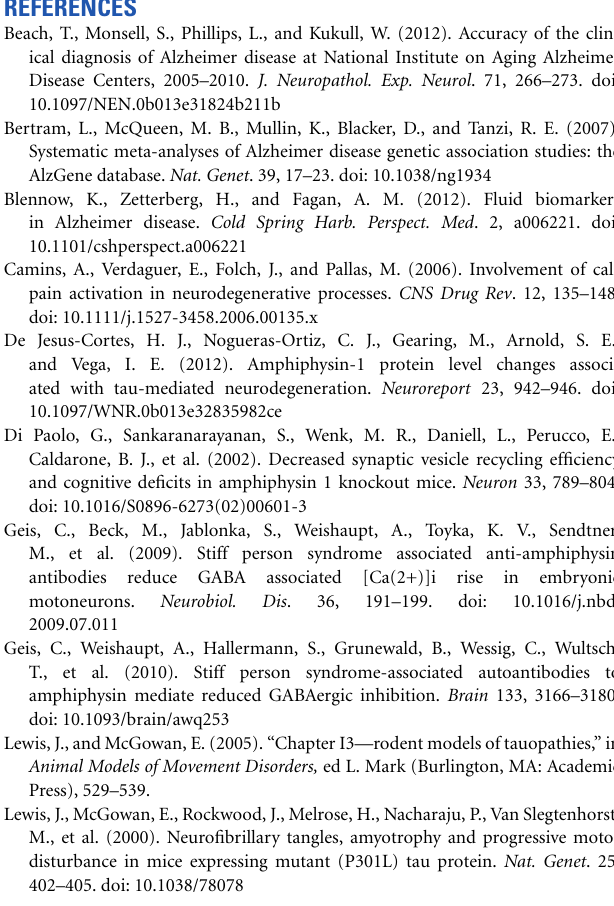
of AMPH1 protein and no detection of anti-AMPH1 antibodies in the serum, further experiments are required to validate these observations. Figure S1 | AMPH1 protein level in the spinal cord of terminally-ill mSOD1 ALS model. Western blot analysis was performed to detect AMPH1 and tau proteins in spinal cord protein extract from three different mSOD1 mice (e.g., ALS #1). Actin was used as loading control. The detected proteins are indicated at the right of the panel. Figure S2 | No detection of anti-AMPH1 antibodies in terminally-ill mSOD1 ALS model. The serum was obtained from the same mice used in Figure S1. The sera were used as primary antibody in a western blot assay where the antigen was recombinant GST-AMPH1. Two different exposures are shown to illustrate the different level of detection between the serum from JNPL3 mice and that from mSOD1 mice. Ponceau stained membrane are shown as loading control. Table S1 | Description of mice used. The table described the genotype, gender, age and motor impairment score of all mice used in the study. Mice were divided in three groups: (1) littermates—mice from the same progeny (brothers and sisters); (2) age-matched—mice that were paired based on their age at the time of euthanizing; (3) not matched—unpaired mice that were included in the respective age